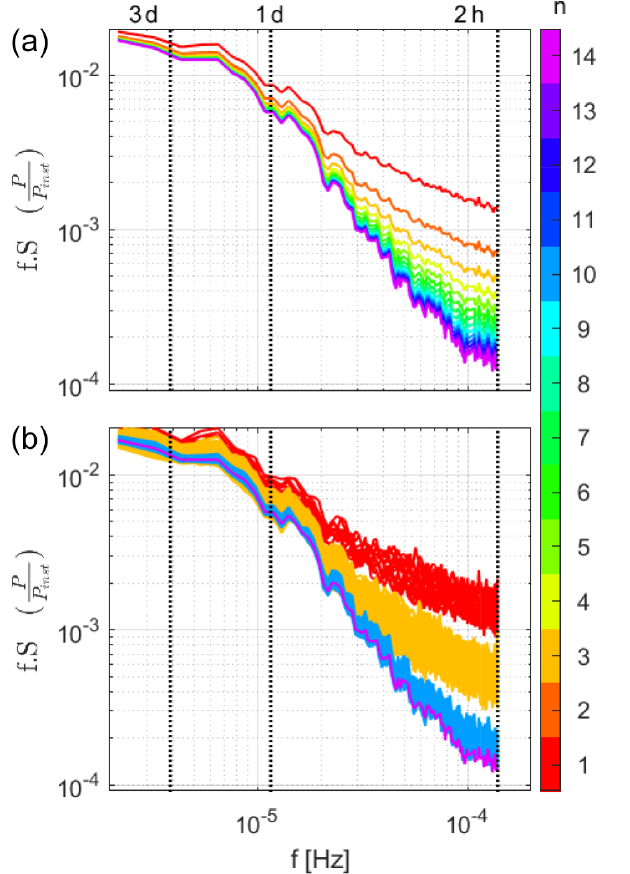
Figure 7. PSDs for up to 14 lumped hourly wind power output time series per installed capacity ( P ). All computations consider P inst an equal distribution of the installed capacity over the considered sites. Colors indicate the number of lumped time series ( n ). (b) All possible combinations for n = [ 1 , 3 , 10 , 14 ] . (a) Averaged PSD of all possible combinations for n = [ 1 , 2 ,..., 14 ]